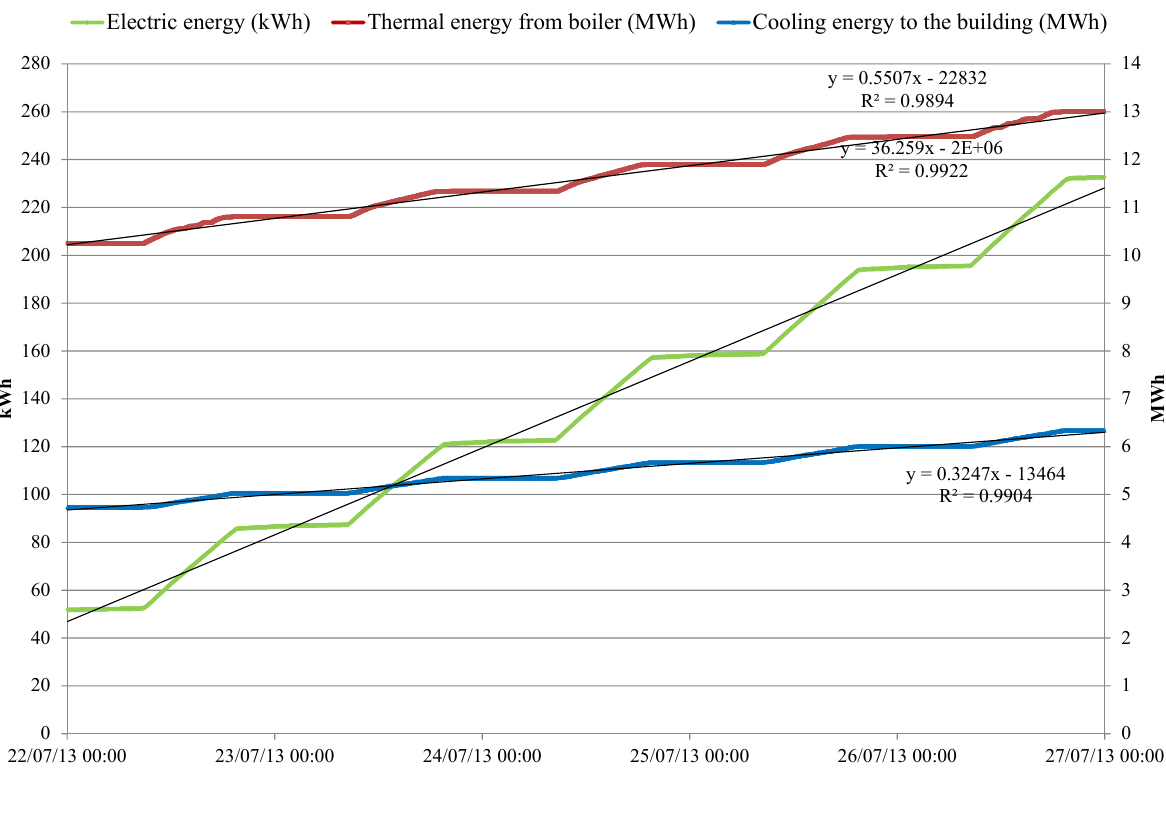
Figure 9. Energy trend during the test